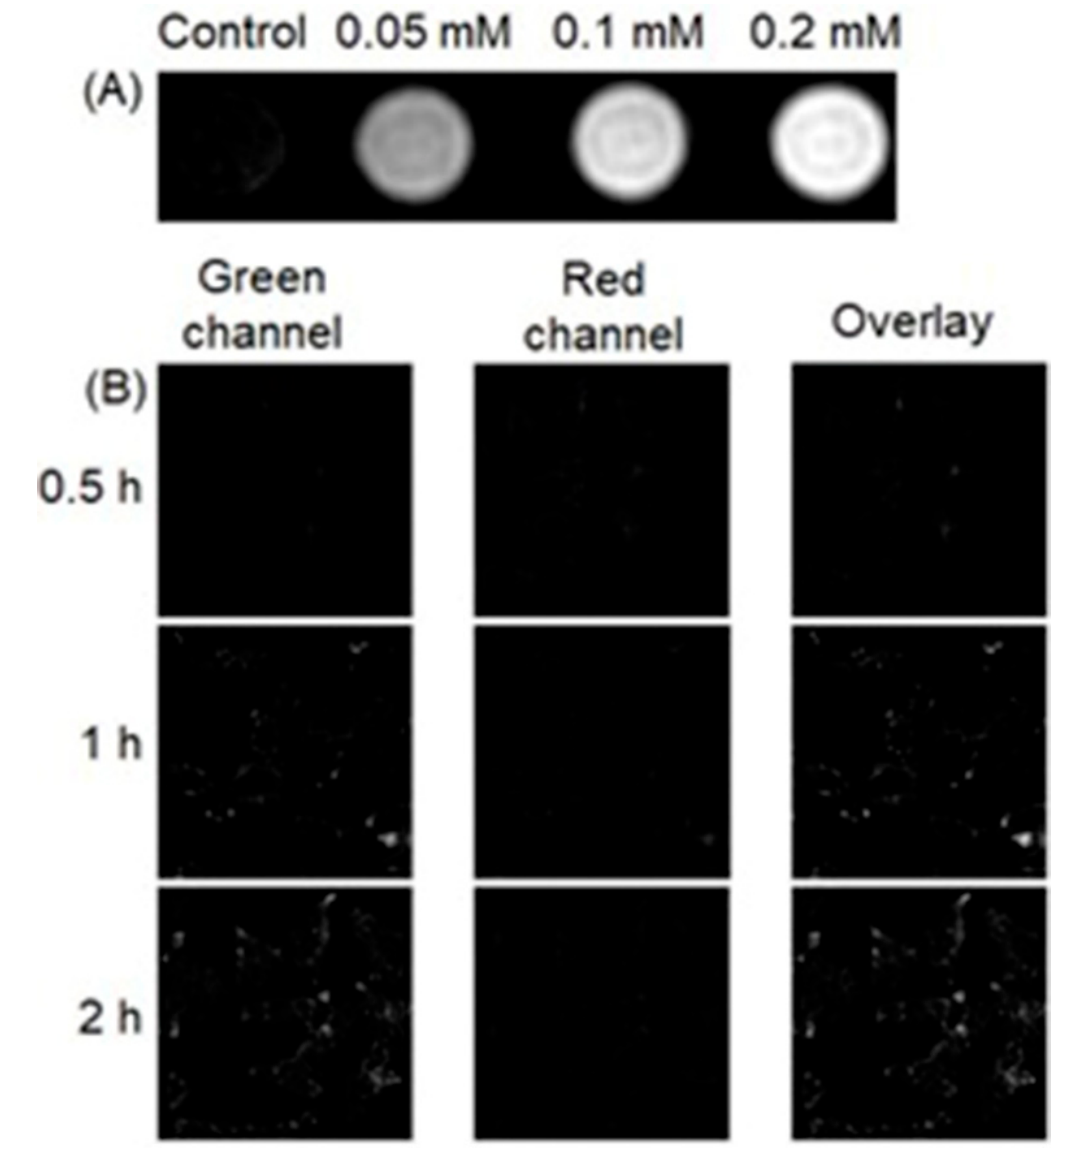
Figure 29. ( A ) T 1 -weighted spin-echo MRI images of HepG2 cells 4 h after incubation with core cross-linked polymeric micelles at varying Gd III concentrations (0–0.2 mM). ( B ) Confocal fluorescence microscopy images of HepG2 cells incubated with cross-linked polymeric micelles. Adapted with permission from Hu, J.; Liu, T.; Zhang, G.; Jin, F.; Liu, S. Macromolecular Rapid Communications , John Wiley and Sons [309].